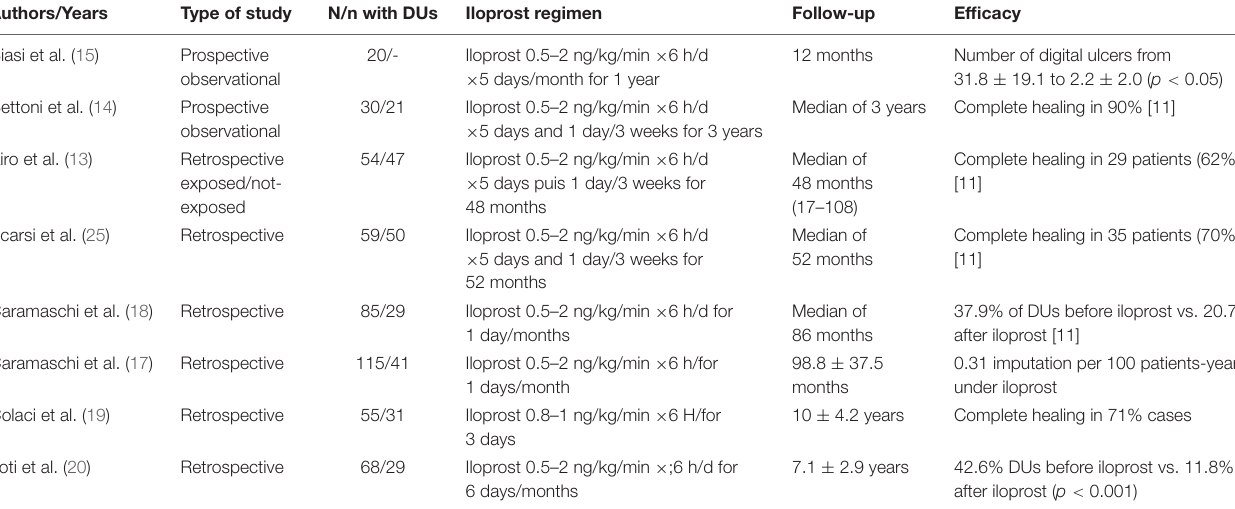
TABLE 4 | Literature review of observational non-randomized trials using iloprost for DUs in systemic